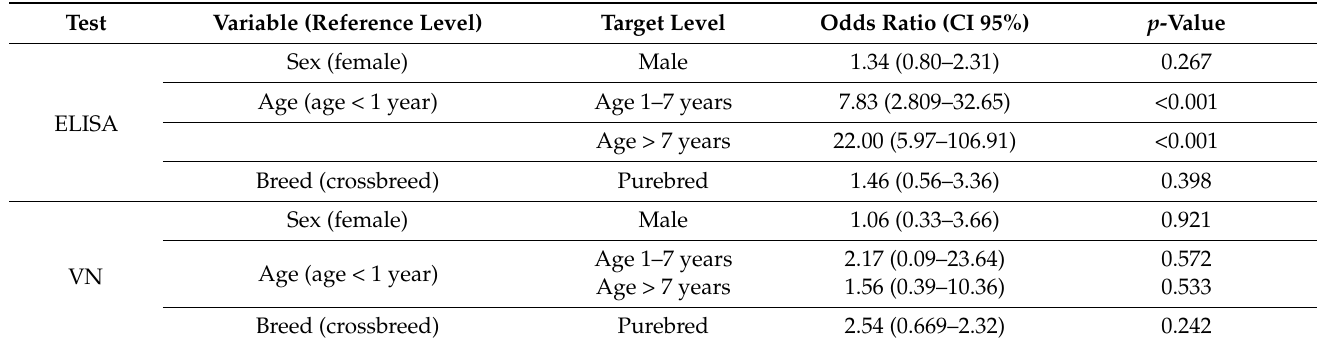
Table 2. Odds ratio, 95 CL, and p -value for the different risk factors calculated for the ELISA and VN